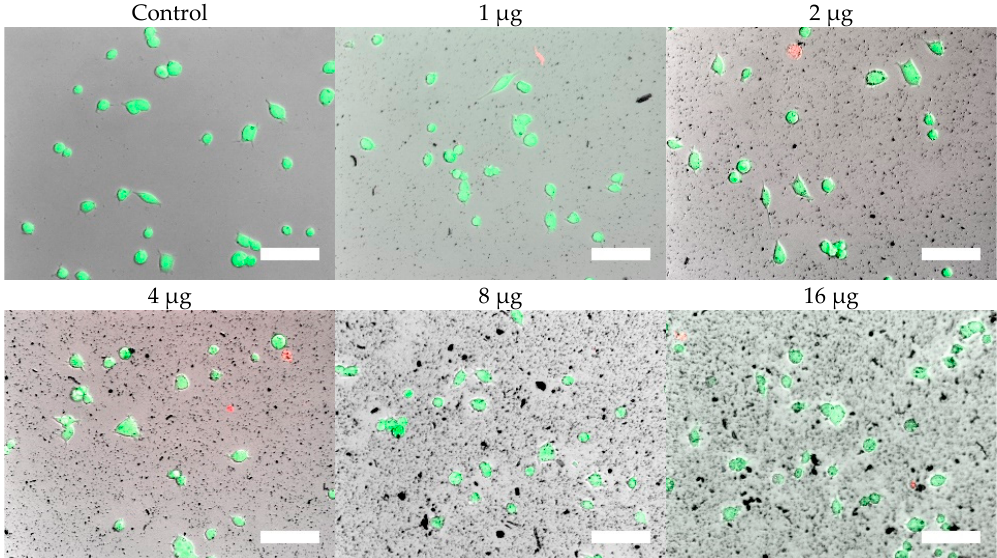
Figure 6. LIVE/DEAD assay results of PC12 cells treated with hydrophilic iron oxide nanoparticles after 24 h. Calcein (green) indicates live cells while ethidium homodimer-1 (red) indicates dead cells. Scale bar = 50 µm.